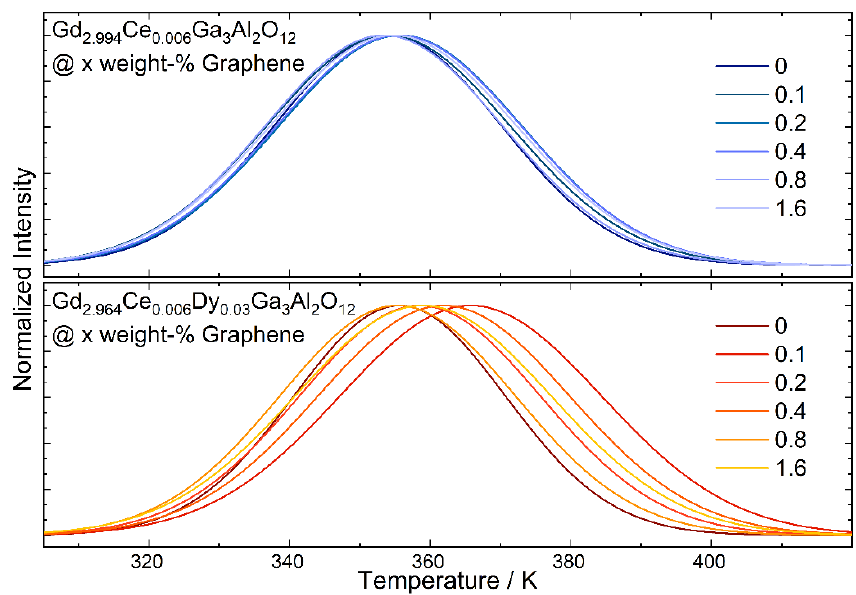
Figure 8. Normalized thermoluminescence (TL) glow curves registered for Gd 2.994 Ce 0.006 Ga 3 Al 2 O 12 and Gd 2.964 Ce 0.006 Dy 0.03 Ga 3 Al 2 O 12 ceramics with different graphene content.